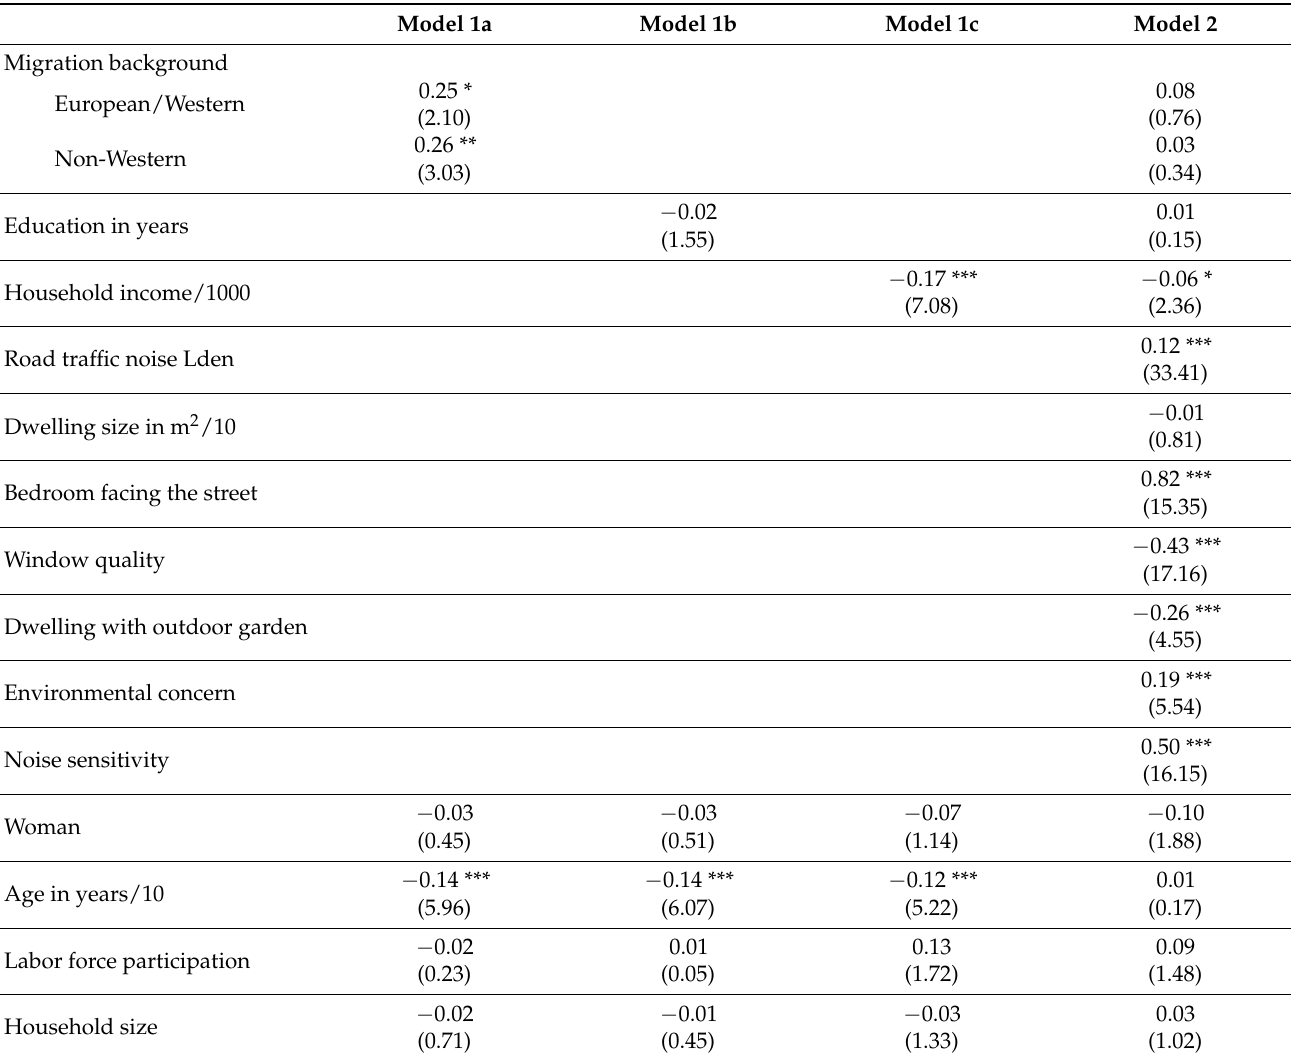
Table 2. Factors affecting annoyance due to road traffic noise (OLS